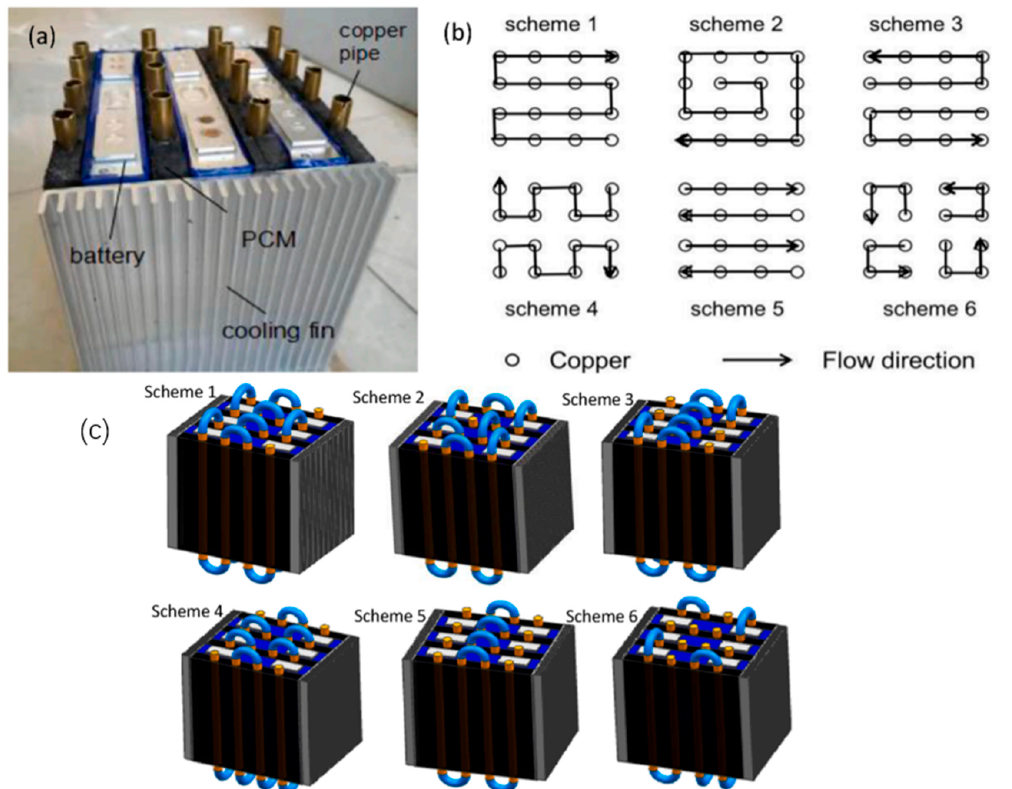
Figure 14. Deformation material and liquid coupling heat dissipation system, ( a ) is the battery pack without the hose installed, ( b ) is the liquid flow direction after the hose is installed, ( c ) is the liquid flow direction model of the battery pack in different schemes [90]. Reproduced from reference [90] with permission from Elsevier B.V., copyright 2021.